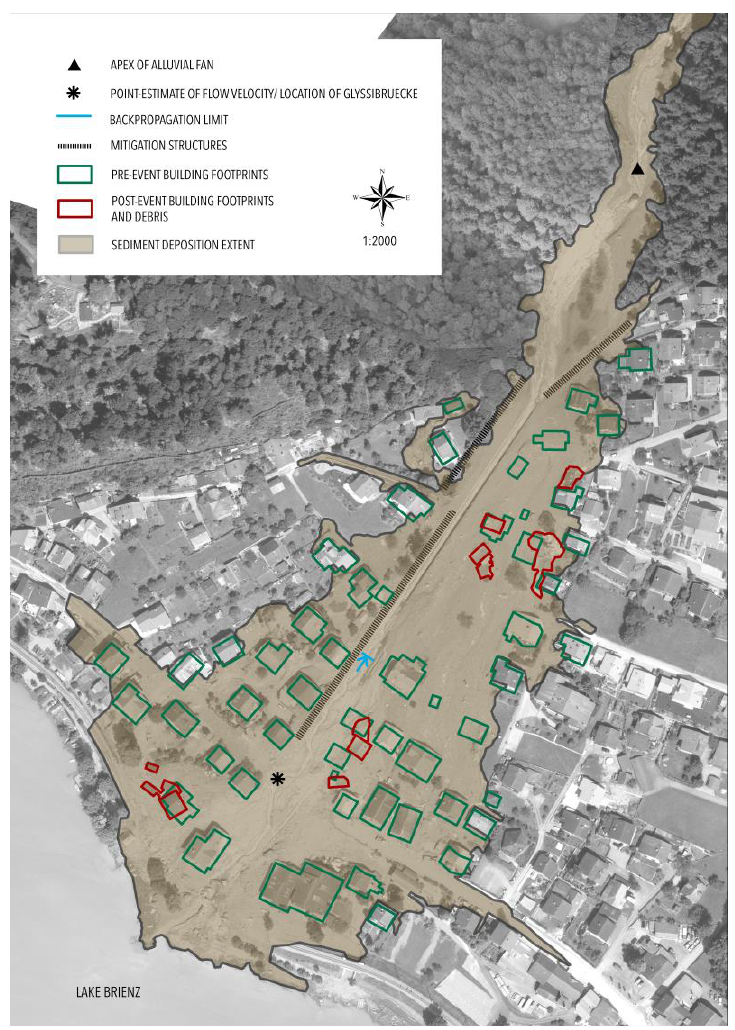
Figure 1. Vectorized post-event orthophotograph [72] capturing the distribution of mud and debris in Brienz.